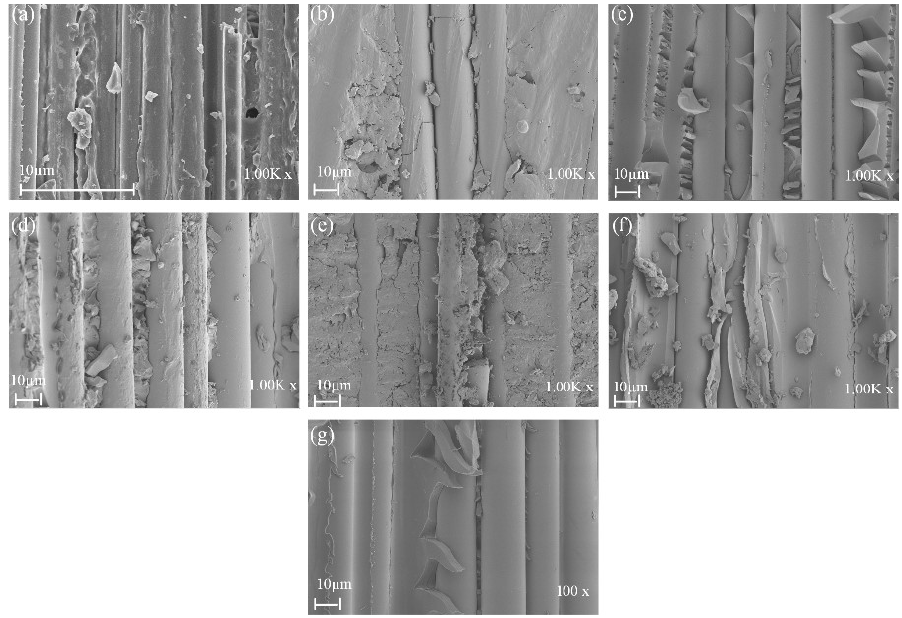
Figure 9. SEM images of tensile specimens in dry condition ( a ) GF ( b ) BF ( c ) GB1 ( d ) GB2 ( e ) GB3 ( f ) GB4 ( g ) GB5.